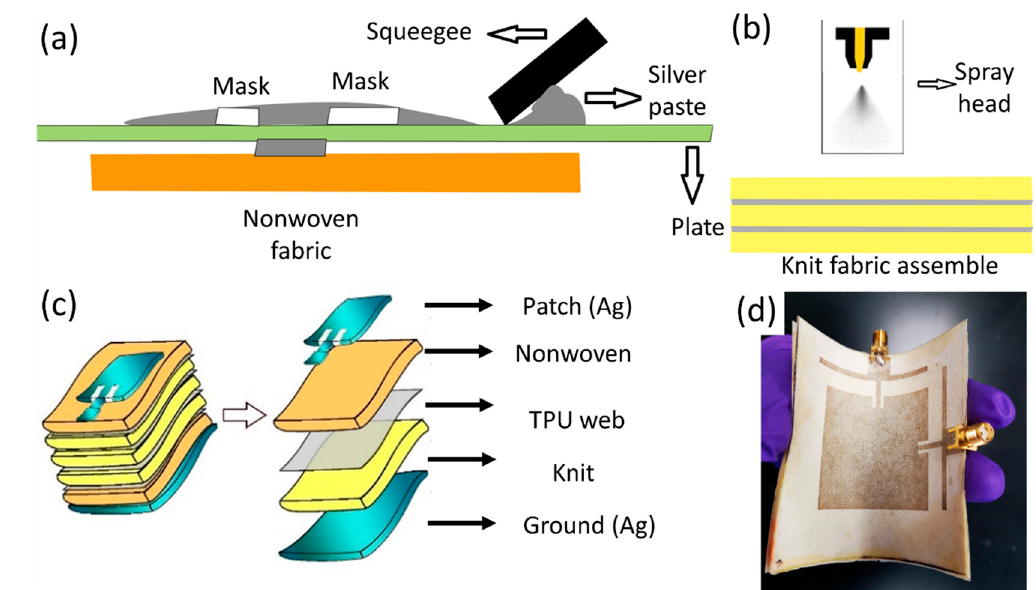
Figure 2. Fabrication of the textile-based antenna. ( a ) Screen printing of the Ag paste from Dupont onto nonwoven fabrics to fabricate the patch and ground. ( b ) Direct-write spray coating of barium titanate (BT) UV curable dielectric ink onto the knit fabric substrate assembly (six layers of knit fabric laminated with a thermoplastic polyurethane (TPU) web) to modify the dielectric constant. ( c ) Final assembly of the printed textile-based antenna (two layers of nonwoven fabric and six layers of knit fabric spray coated with BT dielectric ink). Exploded views indicate the different layer compositions. ( d ) Final product image of the printed textile-based antenna.